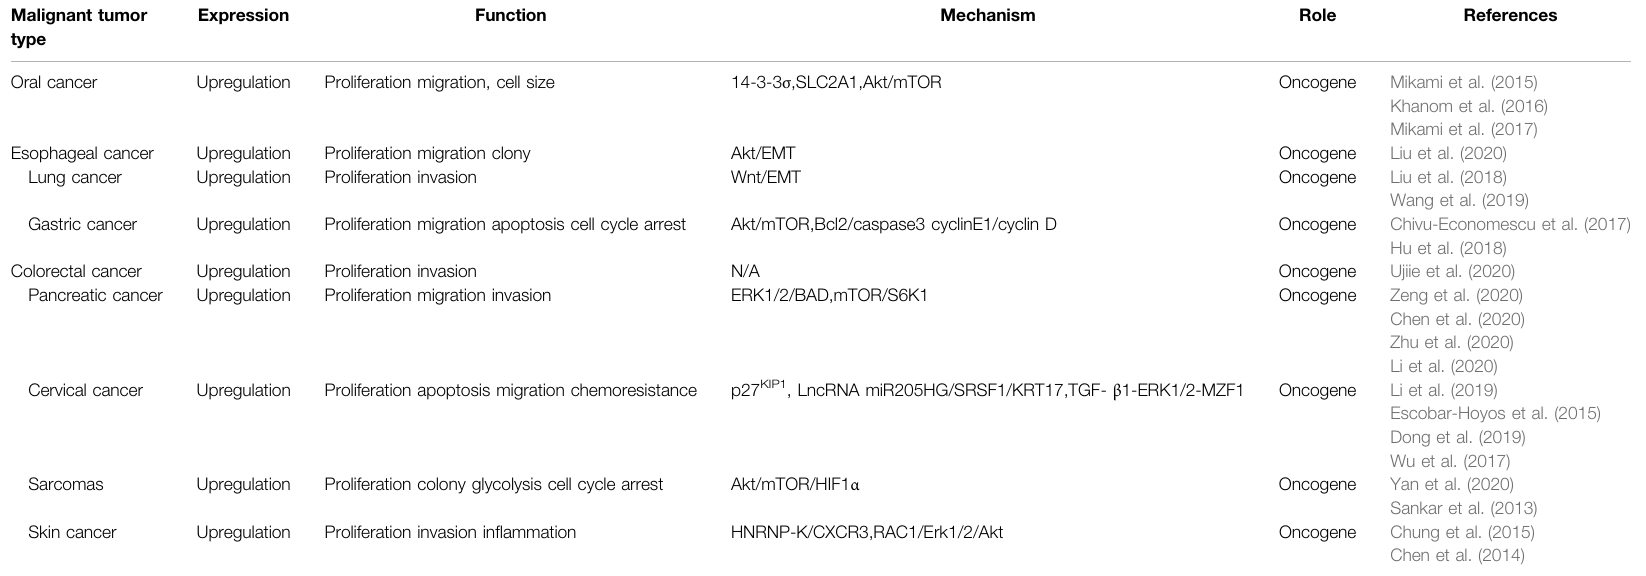
TABLE 2 | Functional characterization of Keratin 17 in various